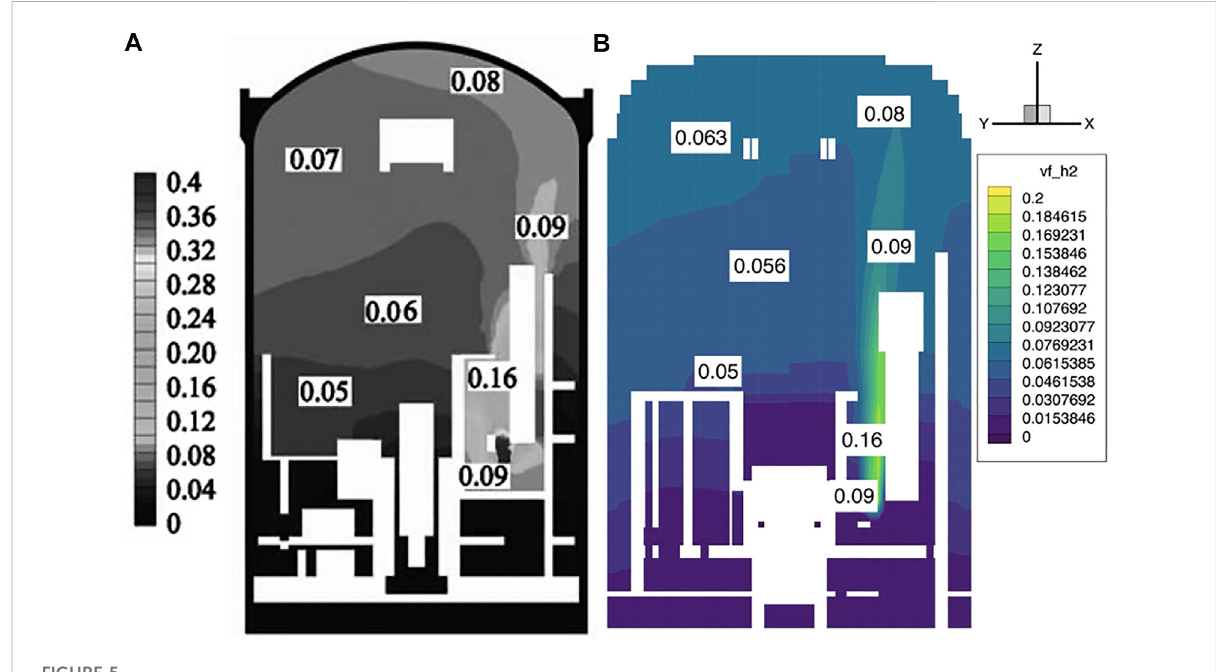
FIGURE 5 Hydrogen concentration fi eld distribution at 1000 s. (A) FLUENT (B)